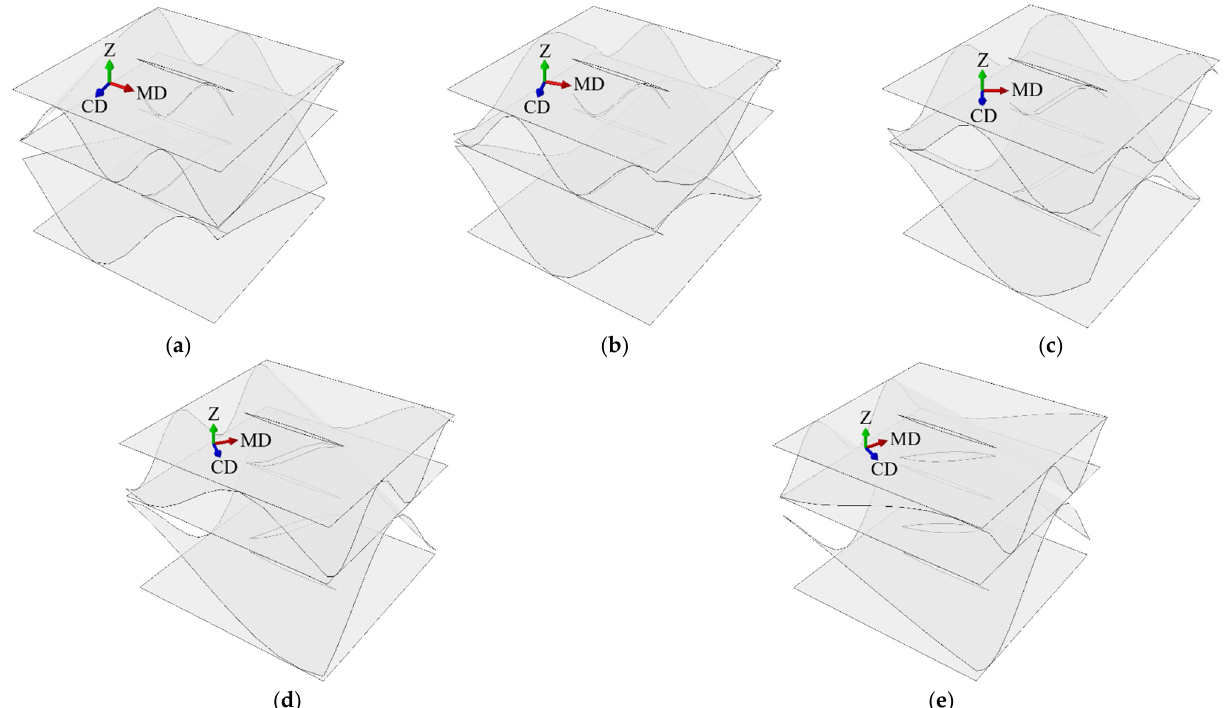
Figure 7. Perforation orientation in sample DW-44-F: ( a ) rotation by 15 degrees; ( b ) rotation by 30 degrees; ( c ) rotation by 45 degrees; ( d ) rotation by 60 degrees; ( e ) rotation by 75 degrees.